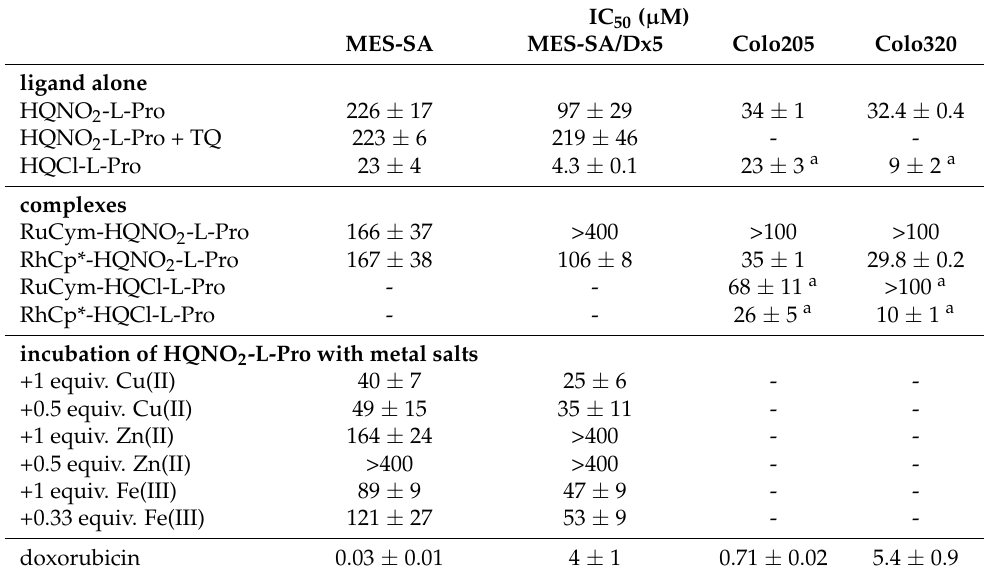
Table 4. In vitro cytotoxicity (IC 50 values in µ M) of HQNO 2 -L-Pro and its RuCym and RhCp* complexes in Colo205, Colo320 {72 h exposure}, MES-SA and MES-SA/Dx5 {144 h exposure} cell lines. IC 50 values obtained for the analogous HQCl-L-Pro compounds are also shown for comparison. IC 50 values obtained for HQNO 2 -L-Pro in the presence of various equiv. CuCl 2 , ZnCl 2 and FeCl 3 . Doxorubicin was used as a